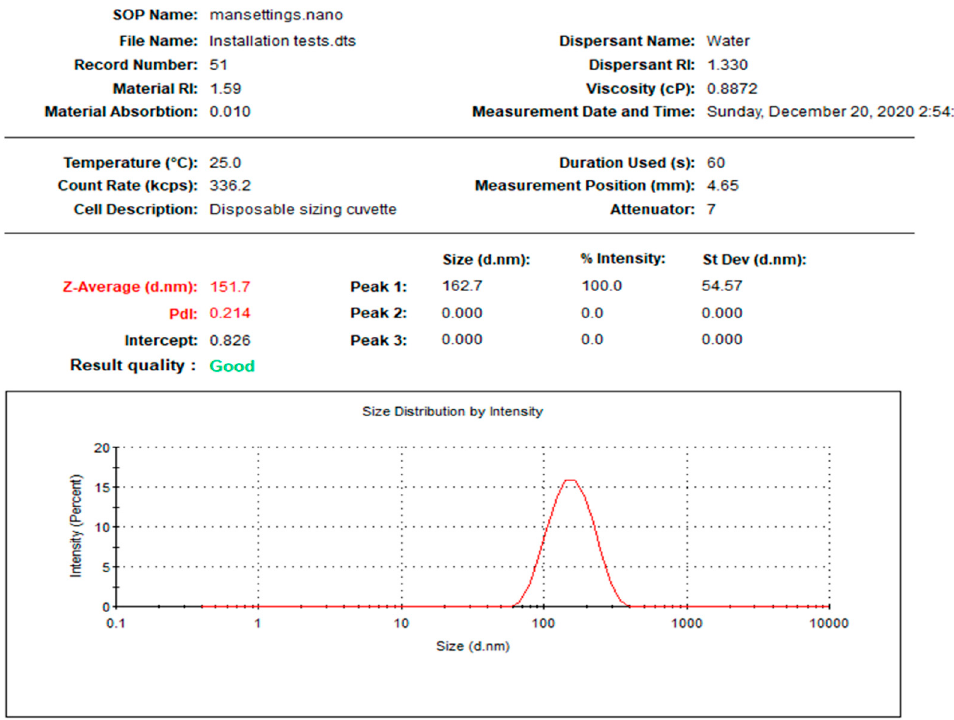
Figure 1. Size distribution of L-AgNPs.